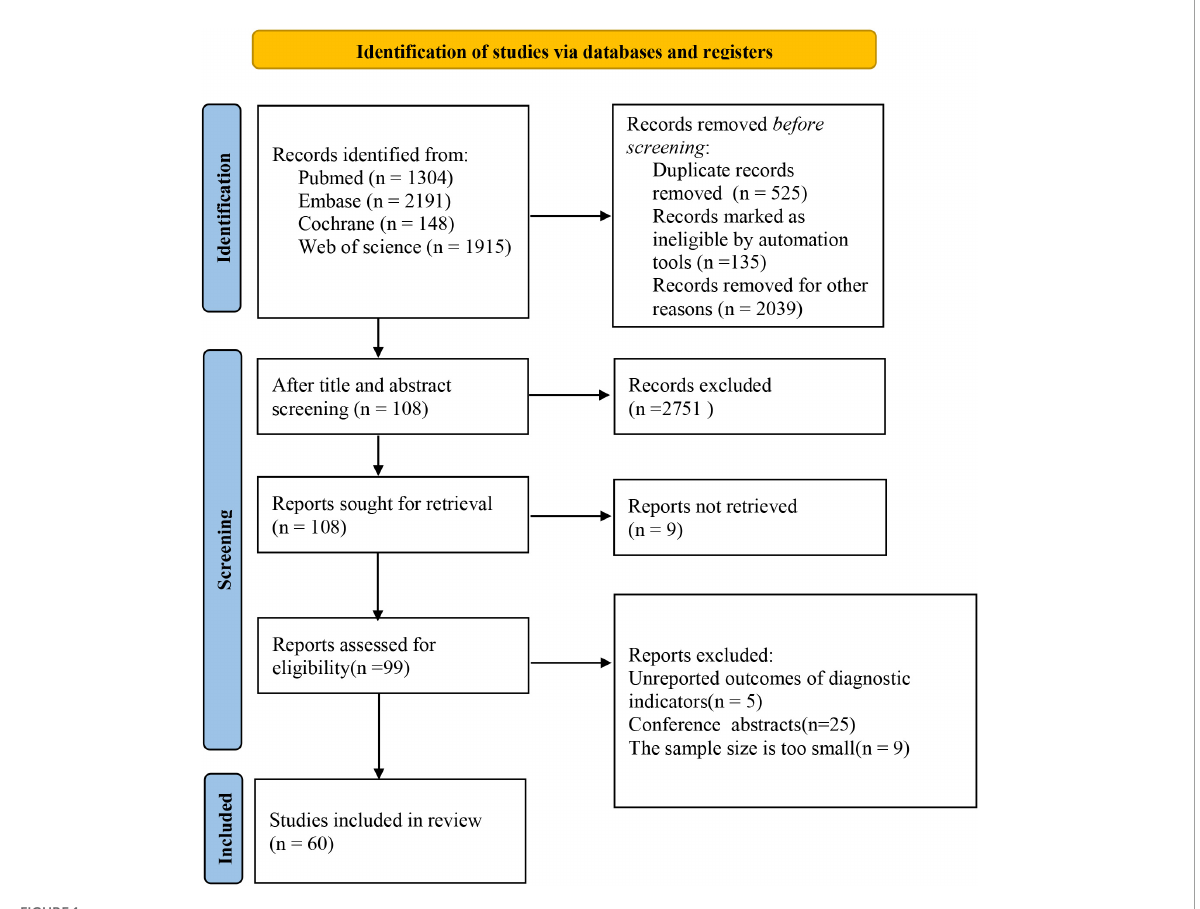
FIGURE1 Flow chart of search process and reasons for